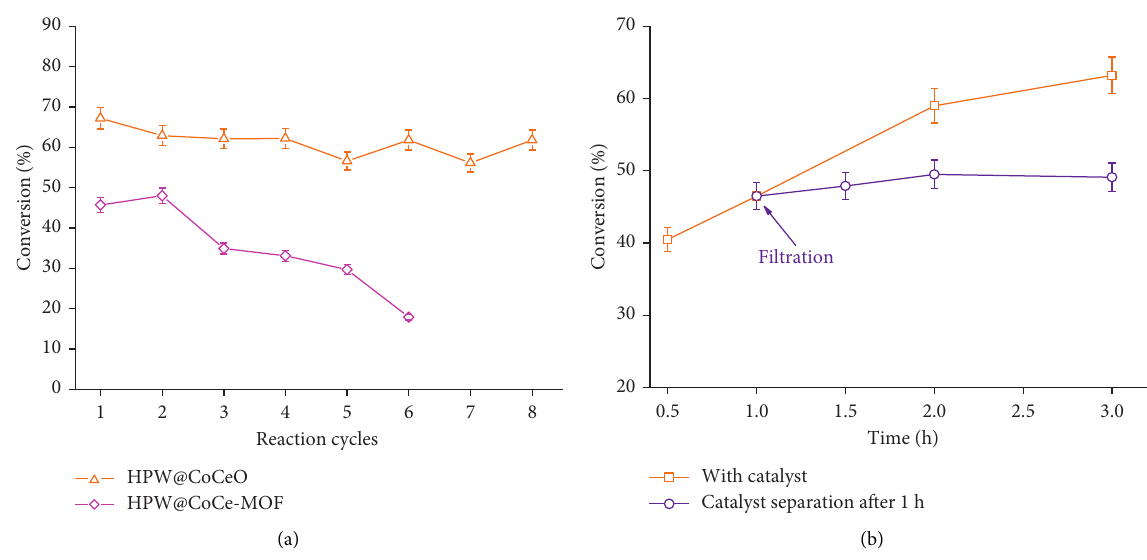
Figure 9: (a) Effect of reusability of the HPW@CoCeO catalyst on the oleic acid conversion. (b) The hot filtration test for